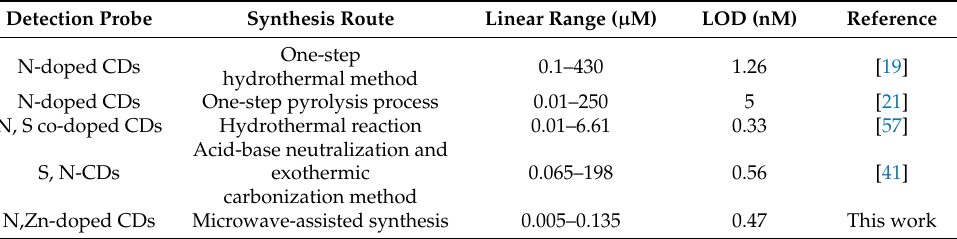
Table 1. Comparison of the as-synthesized N,Zn-CDs with some reported CD fluorescent sensors for detecting Cr(VI)